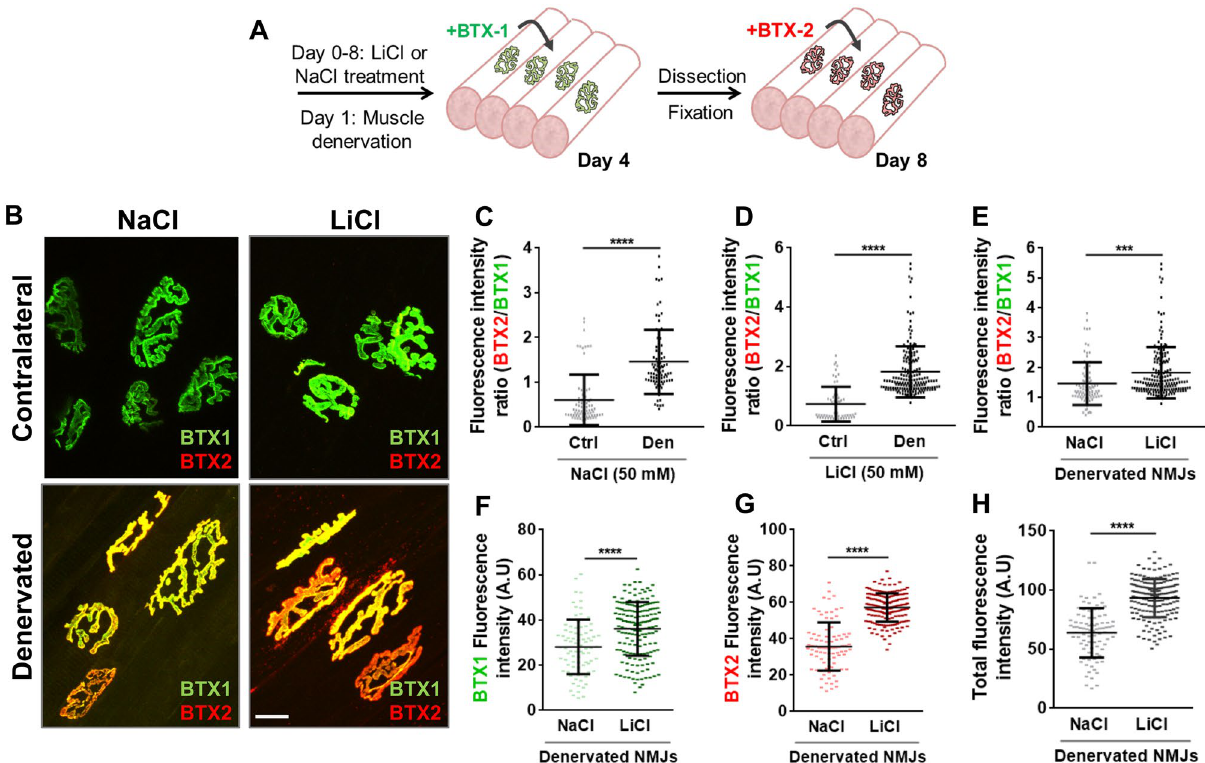
Figure 5. Lithium stimulates nAChR turnover and density in denervated NMJs. ( A ) Experimental design used to analyse the effect of lithium on nAChRs turnover in denervated NMJs. Since one day before facial nerve cut, lithium or sodium chloride were subcutaneously injected on top of the LAL muscle daily until BTX2 labelling. The initial surface nAChR pool was labelled 3 days after facial nerve cut (BTX1) while newly incorporated nAChRs (BTX2) were stained 7 days after nerve cut. ( B ) Pictures show representative confocal images of merged BTX1 and BTX2 staining in denervated and contralateral LAL muscles from sodium or lithium-treated animals. Bar = 20 µm. ( C–E ) nAChRs turnover was determined by quantifying the BTX2/BTX1 fluorescence intensity ratio. BTX1 ( F ) and BTX2 ( G ) fluorescence intensities are shown to determine the contribution of each nAChR pool in all tested conditions. ( H ) Total fluorescence signal of BTX1 plus BTX2 in entire endplates was also quantified. Graphs represent mean values ± SD along with individual data for sodium or lithium condition. For statistical analyses, a t -test was employed for comparison between controls and lithium-treated groups from 30 to 40 NMJs per animal (N = 3 animals per group). **** p < 0.0001; *** p < 0.001; ** p < display faster turnover than adult nAChRs 45,46 , we analysed the potential effect of lithium on the expression of the nAChR γ-subunit. As expected, innervated muscle extracts contained almost undetectable levels of the nAChR γ-subunit (Fig. 7A). Although denervation induced a strong increase in a ~ 60 kDa immunopositive band, the abundance of the nAChR γ-subunit was not significantly altered by lithium treatment (Fig. 7A). Secondly, we considered that amongst its downstream effectors, lithium inhibits GSK3β, which leads to the cytosolic accu- mulation of β-catenin, a central mediator of both canonical Wnt signalling activity and cell–cell interactions 8,9 . Interestingly, lithium treatment rescues NMJ alterations in mice expressing a truncated form of the muscle spe- cific kinase receptor (MuSK), a central mediator of nAChR aggregation, likely via increasing β-catenin distribu- tion in the endplate area 47 . Therefore, we studied the potential involvement of β-catenin on the lithium-mediated modulation of nAChR stability. Western blot analyses showed that lithium treatment of control innervated mice results in the accumulation of a ~ 100 kDa β-catenin immunoreactive band compared to sodium-treated mice (Fig. 7A). LAL muscle denervation triggers a strong β-catenin increase in control NaCl-treated mice, which was not further altered by lithium treatment (Fig. 7A). Immunofluorescence analyses showed that β-catenin distributed in both presynaptic axons and within the endplate in control innervated muscles (Fig. 7B), a pat- tern that was not significantly modified by lithium treatment. Interestingly, even though muscle denervation strongly decreased β-catenin detection in the endplate region of NaCl-treated mice, lithium-treated fibres retain β-catenin staining in specific foci of the synaptic region (Fig. 7C). Therefore, while muscle denervation increases the levels of β-catenin and the nAChR γ-subunit, lithium does not modify the levels of these proteins; however, the distribution of β-catenin is locally modified by lithium.